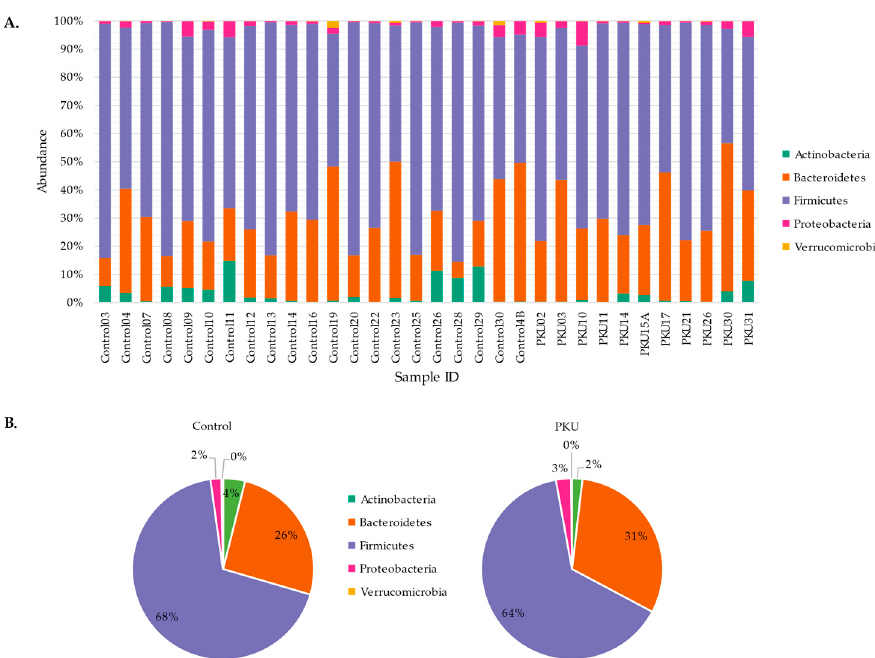
Figure 1. Phylum-level comparison between PKU and control samples. Stacked histogram ( A ) and pie graph ( B ) representing the individual and average abundance of phyla (> 1% relative abundance) in PKU and control samples.